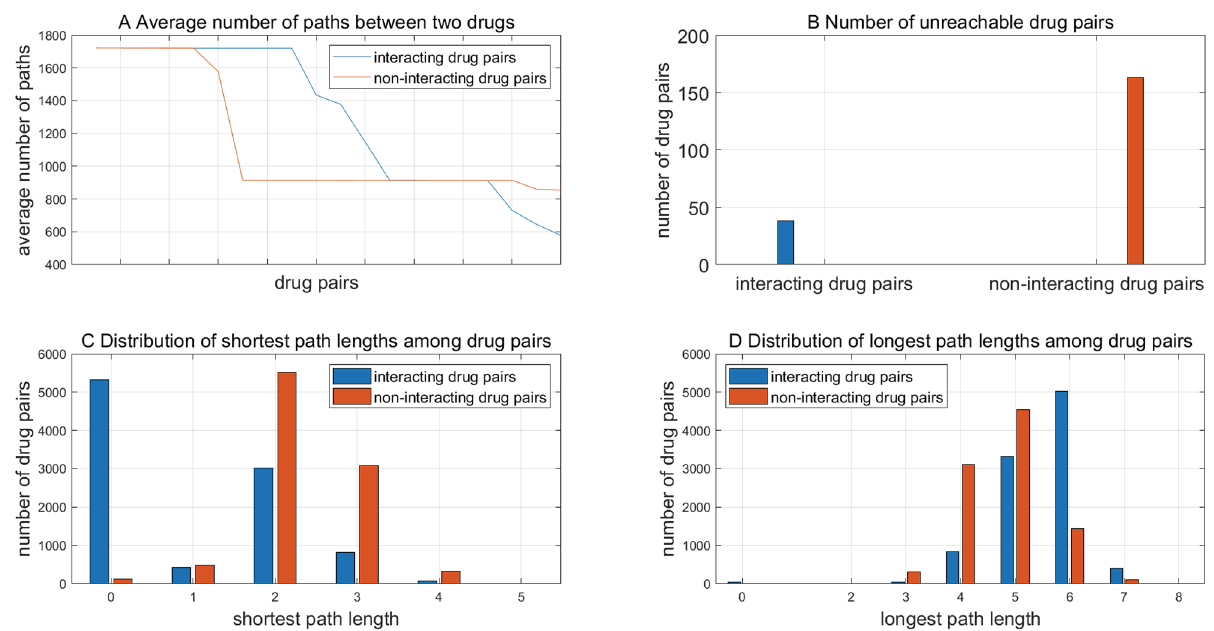
Figure 3. The statistics of average number of paths, shortest path lengths and longest path lengths between two